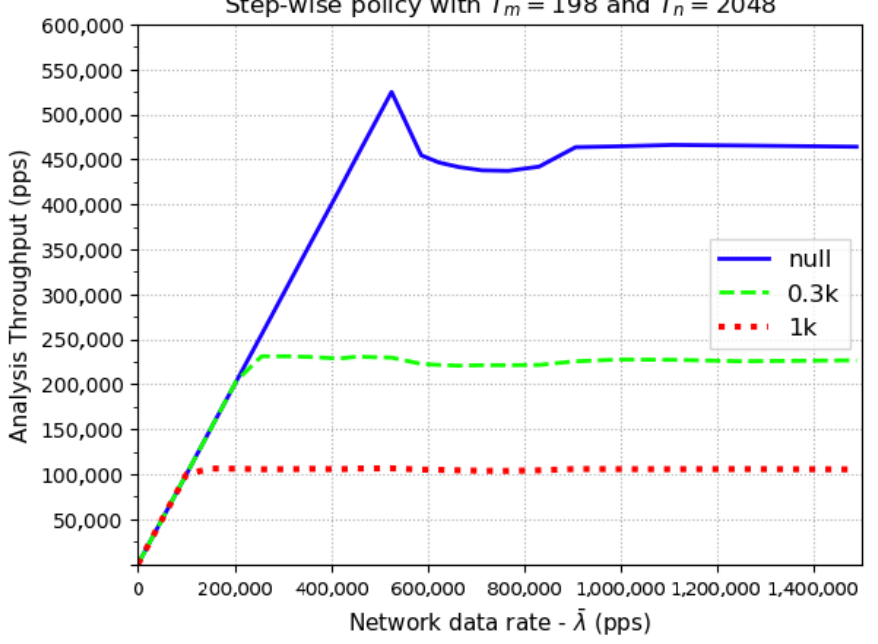
Figure 11. Performance simulation for step-wise